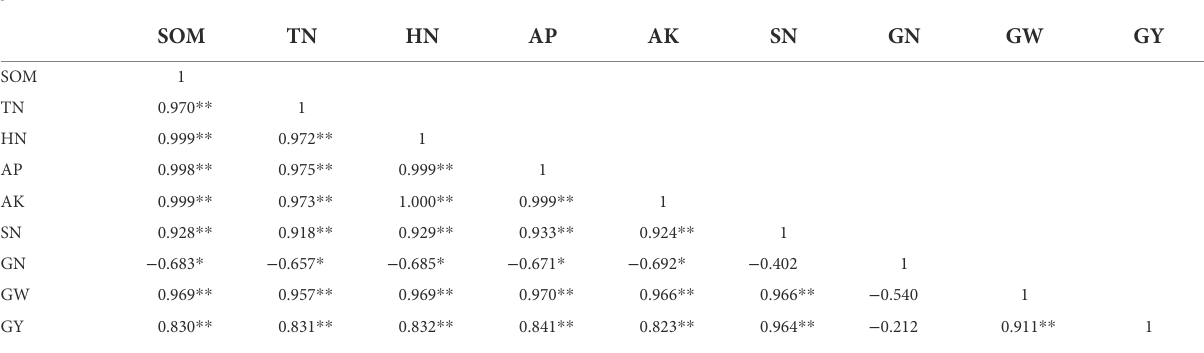
TABLE 5 Analysis of correlations among mean soil nutrients in 0–40 cm soil layer during whole wheat growth stages, yield components, and grain yield in 2017/18 and 2018/19 (n = 12).